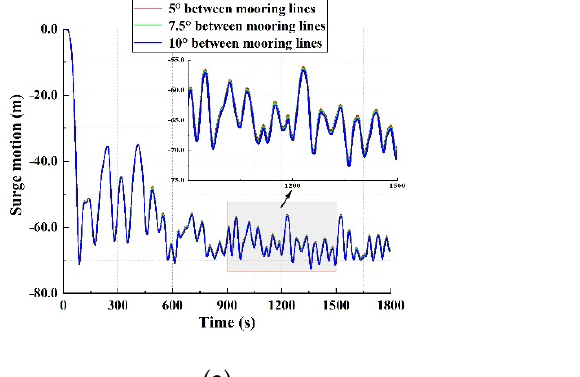
Figure 24. Comparison of three groups of mooring lines with angles of 5°, 7.5°, and 10°. ( a ) Surge motion under level ice loads; ( b ) pitch motion under broken ice floes loads.